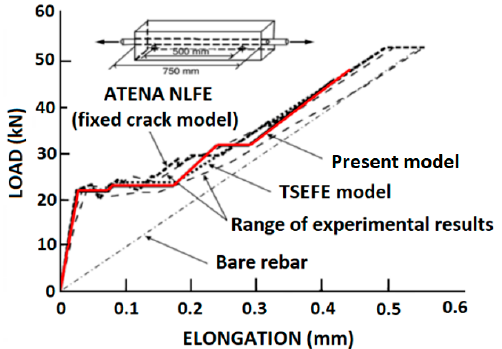
Figure 9. Comparison of analysis methods with Hartl’s test results.